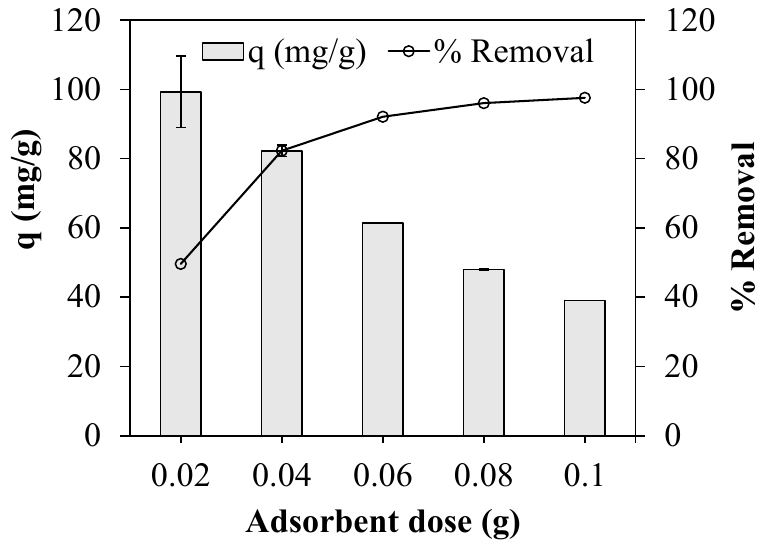
Figure 7. Effect of adsorbent dose on Cu(II) adsorption. Here, q denotes the adsorption capacity.